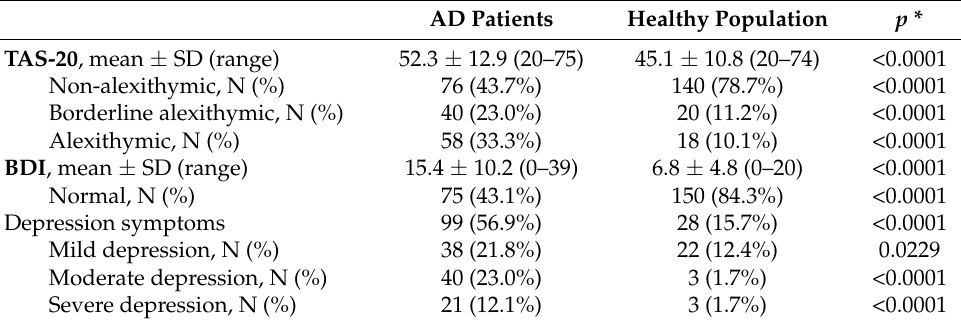
Table 2. Toronto Alexithymia Scale (TAS-20) and Beck Depression Inventory (BDI) continuous and categorical data.